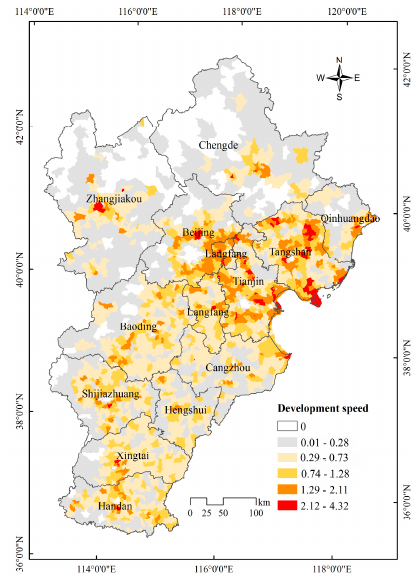
Figure 3. Spatial pattern of development speed in Beijing-Tianjin-Hebei urban agglomeration during 2000–2012.